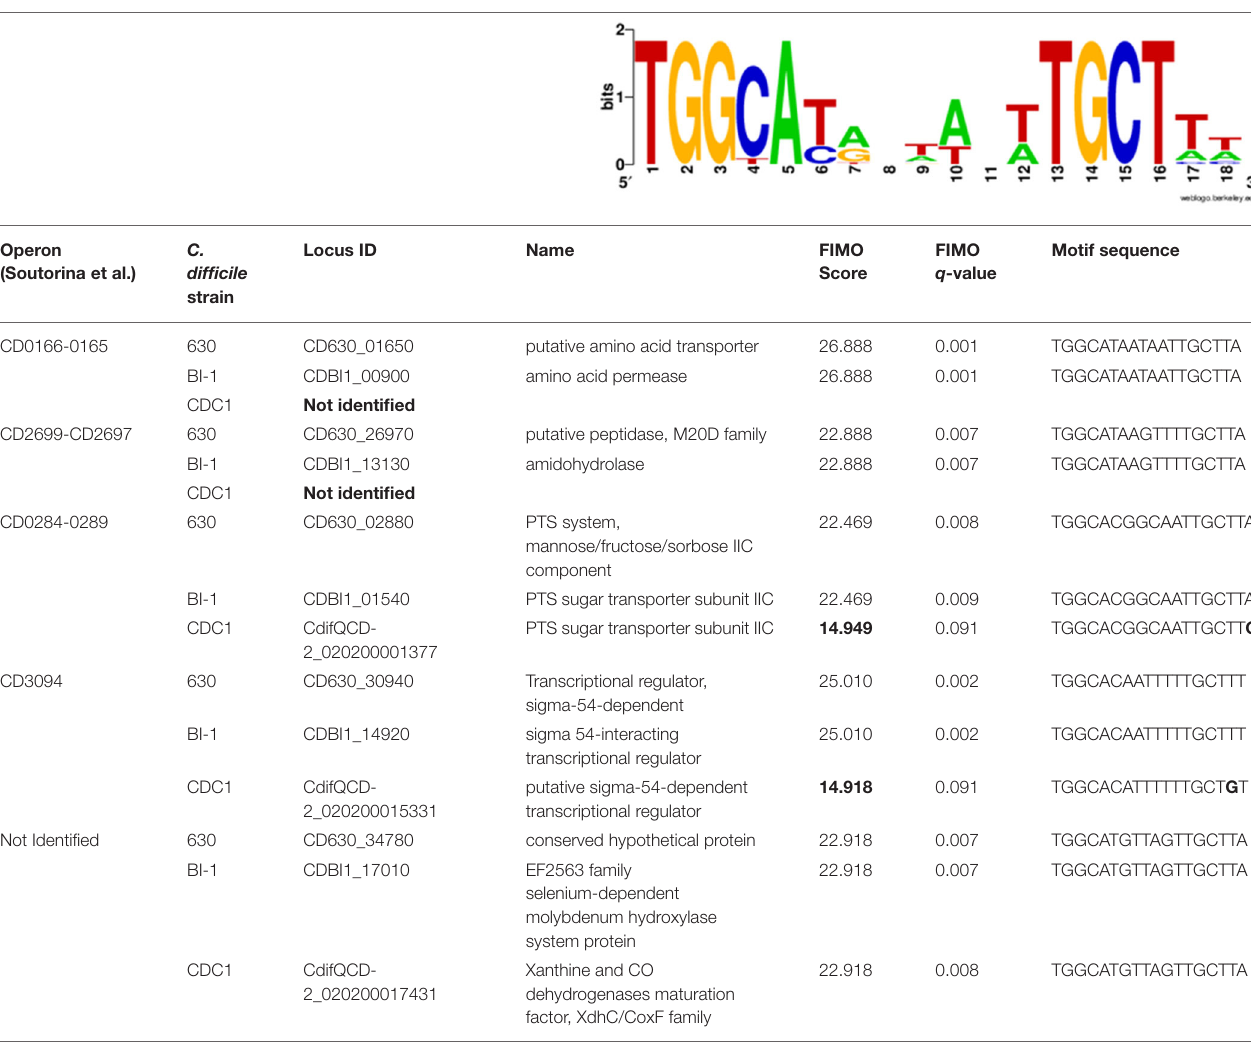
TABLE 1 | sigL positional weight matrix and sigL motif sequences with FIMO scores in C. difficile strains 630, BI-1, and CDC1.